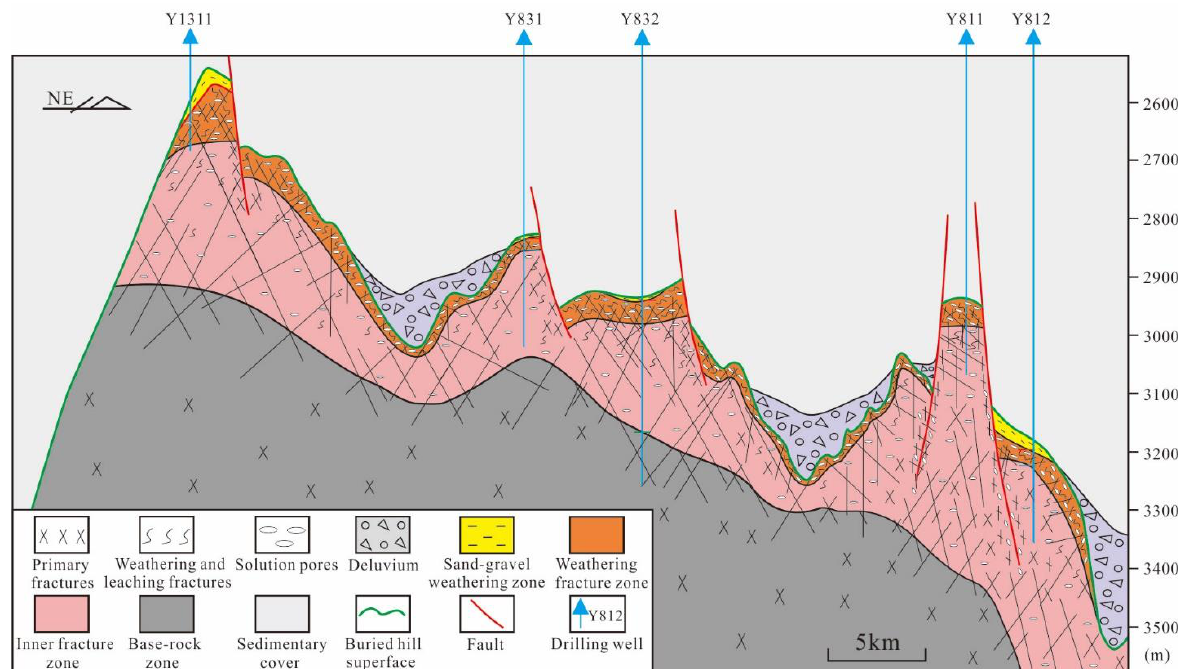
Figure 3. Zonation model of intrusive rock buried-hill in the Y area, Qiongdongnan Basin. The location of the section is shown in Figure 1a,b.